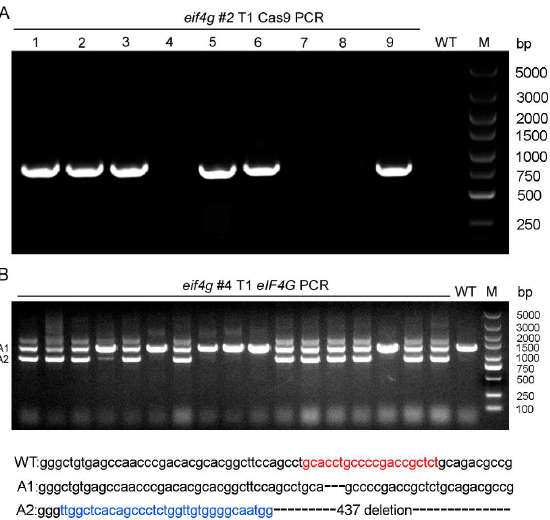
Figure 2. Transgene cas9 and mutation screening in T1 generation rice plants. ( A ) Transgene screening of eIF4G -targeted T1 transgenic plants by genomic DNA PCR. WT: wild-type plants. M: DNA marker. ( B ) eif4g mutant screening in eIF4G -targeted T1 transgenic plants (#4) by genomic DNA PCR. WT: wild-type plants; DNA sequence deletions are denoted by black dashes, and DNA sequence insertions are denoted by blue letters. The sgRNA target sequences are shown in red letters. M: DNA marker. For the T0 generation of eif4g #4 mutants containing eIF4G small fragments (A2), we analyzed these eIF4G small fragments in the T1 population plants with PCR. Our results